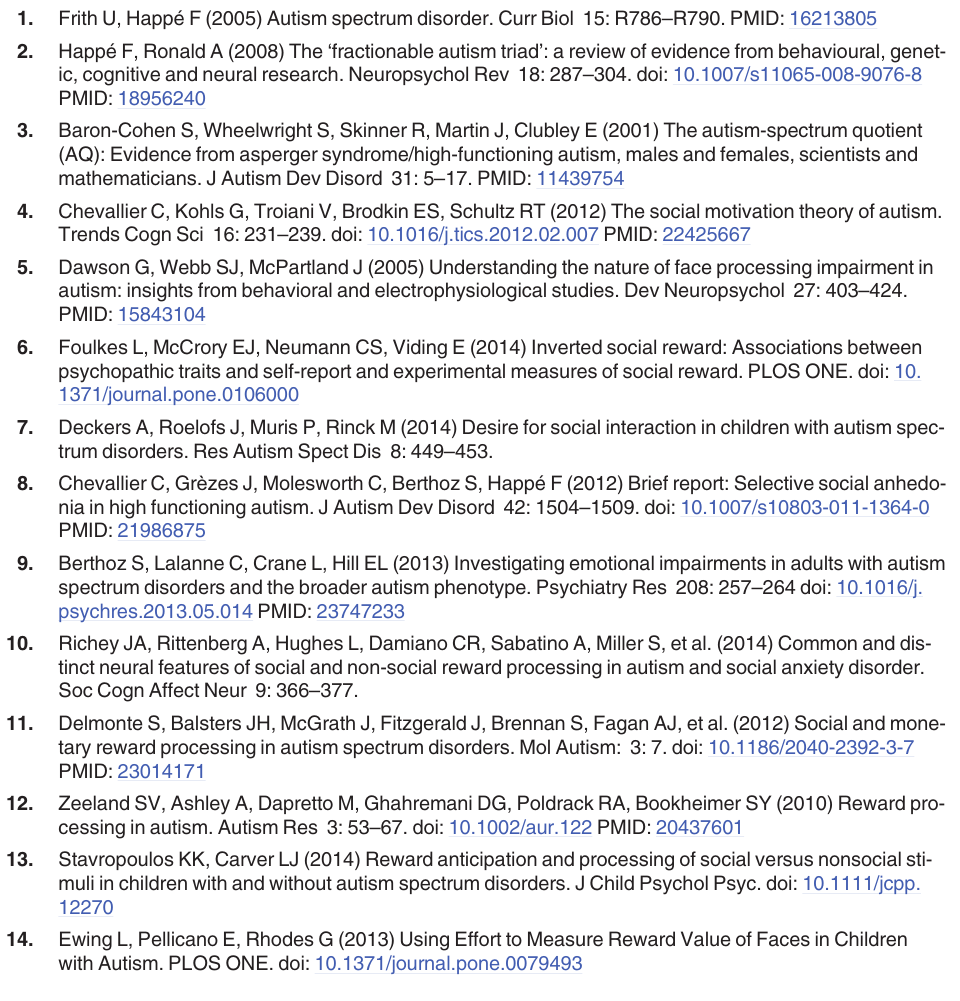
S1 Table. Descriptives for males and females for all questionnaire measures. S2 Table. Numbers of participants in cut-off categories for the AQ and TAS-20.